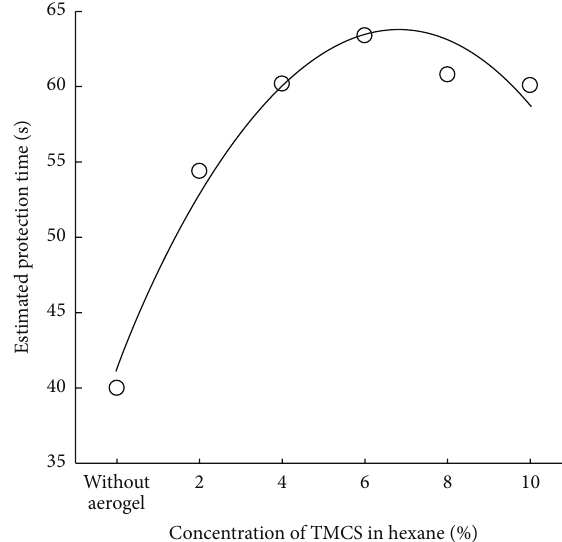
Figure 7: Estimated protection time of the aerogel blankets versus the concentration of the TMCS in